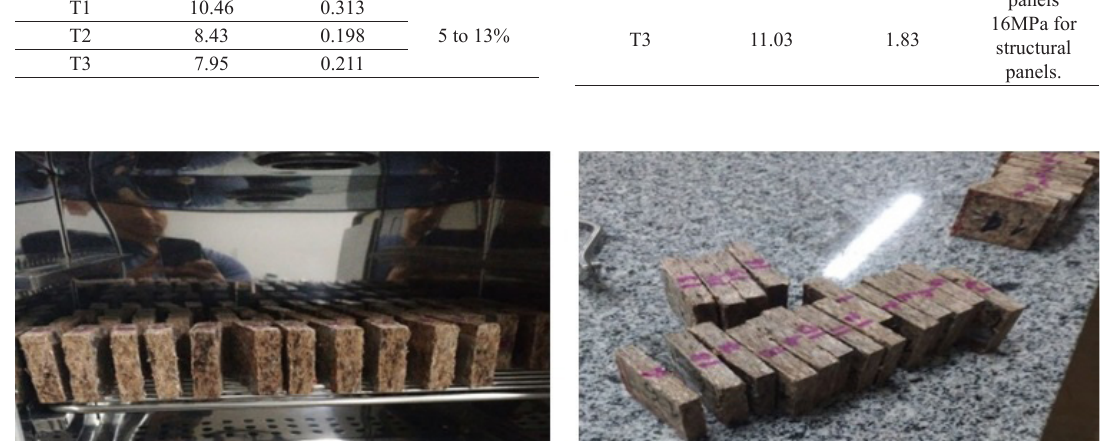
Table 3. Average specimen moisture, standard deviation and value required by the standard. Treatments